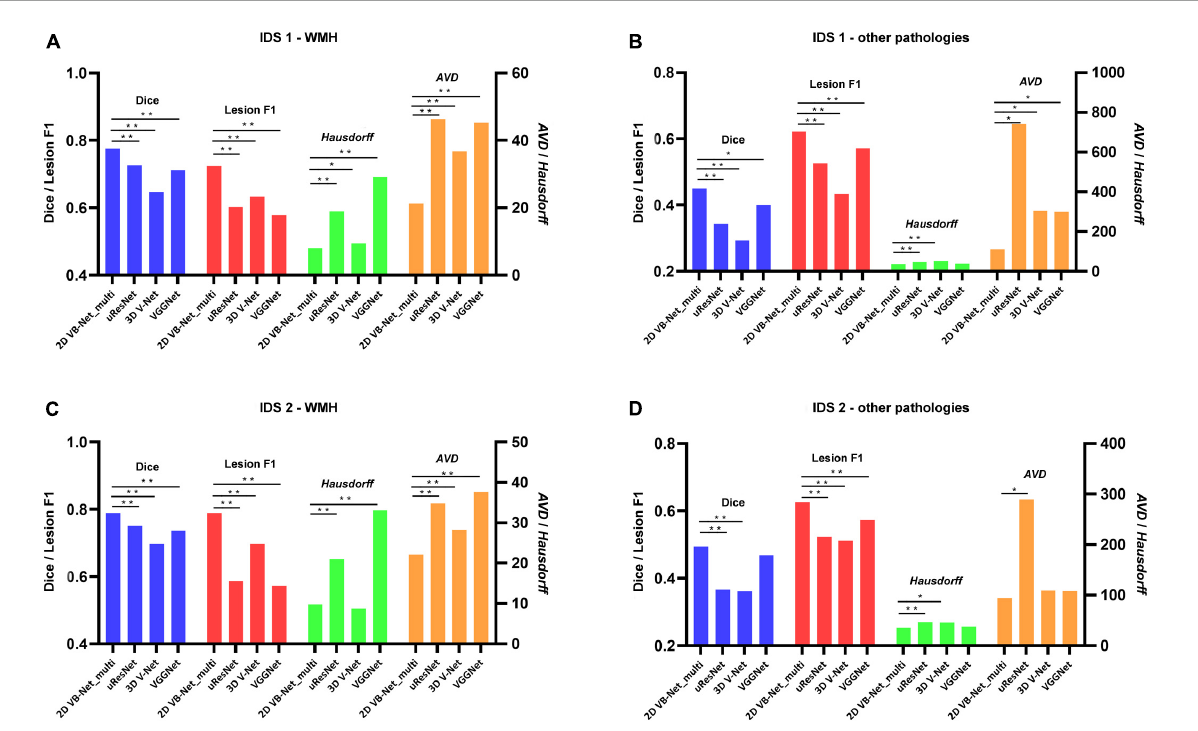
FIGURE5 Performance differences between 2D VB-Net and the other state-of-the-art algorithms on the two independent in-house datasets. The upper row shows the differences in segmentation performance in WMH (A) and other intracranial pathologies (B) among the four methods on IDS 1; (B) the lower row shows the differences in segmentation performance of WMH (C) and other pathologies (D) among the four methods on IDS 2. The performance of each algorithm was measured by Dice, lesion F1, Hausdorff , and AVD . Of note, the four algorithms were trained and evaluated based on multi-modality MR images (T1-weighted, T2-weighted, and FLAIR), and a lower value of Hausdorff and AVD indicates better performance of the algorithm. IDS, independent dataset. *, ** P -value of two-tailed paired t -test between the performance of 2D VB-Net _multi and the other algorithms; *, P < 0.05 significance level; **, P < 0.001 significance level.